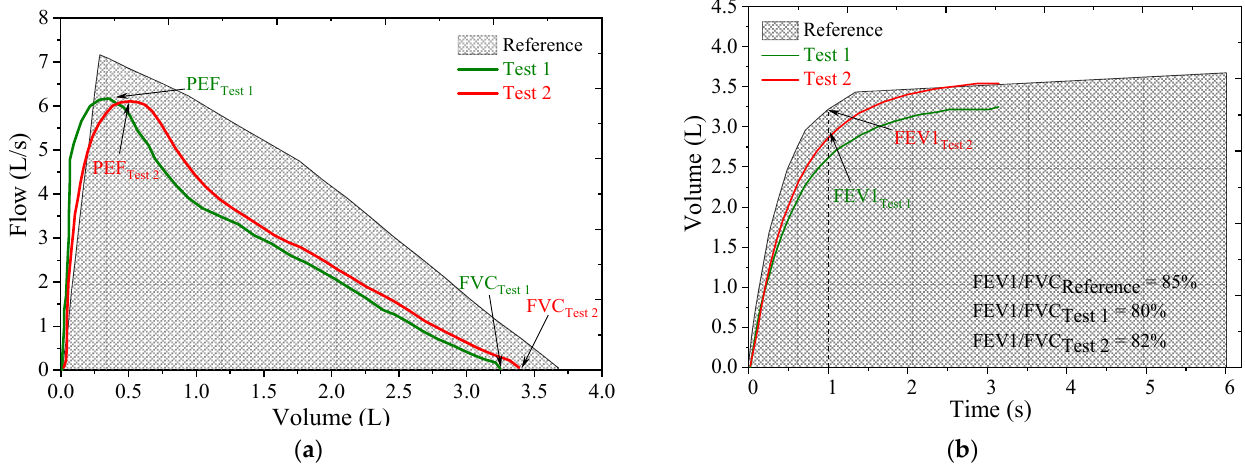
Figure 10. Commercial spirometer and reference spirometric curves: ( a ) flow–volume curve and ( b ) volume–time curve.